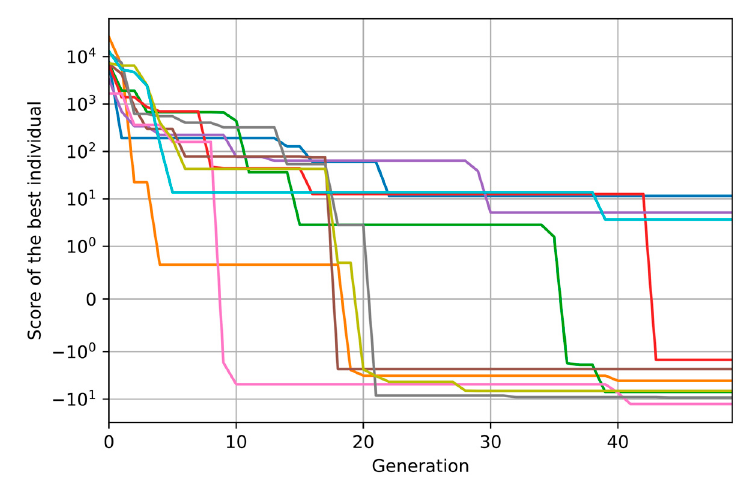
Figure 2. Fitness function values of the best individual in the function of generation for 10 consecutive gains selection attempts.